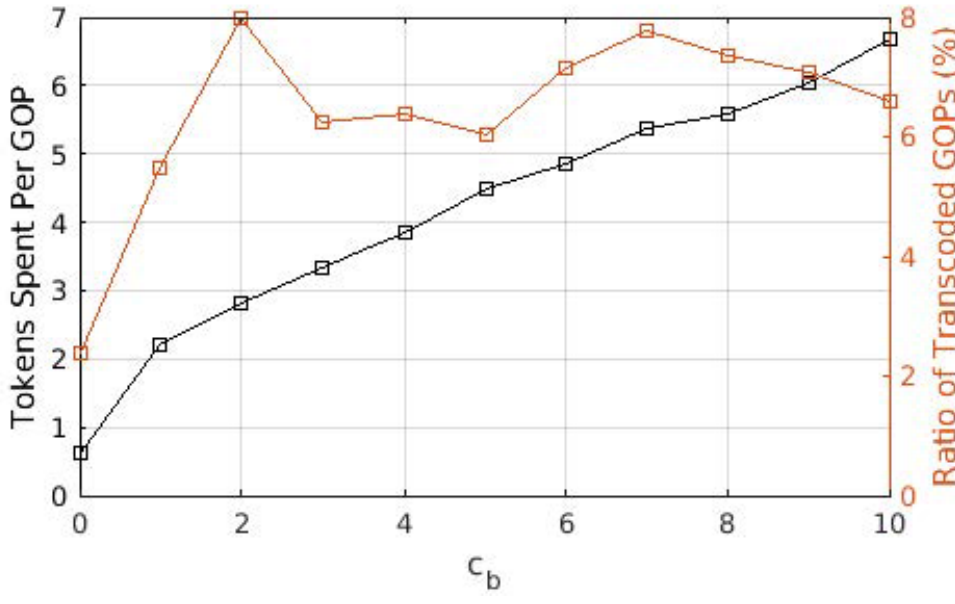
Figure 3. Tokens paid per GOP for different values of c b .